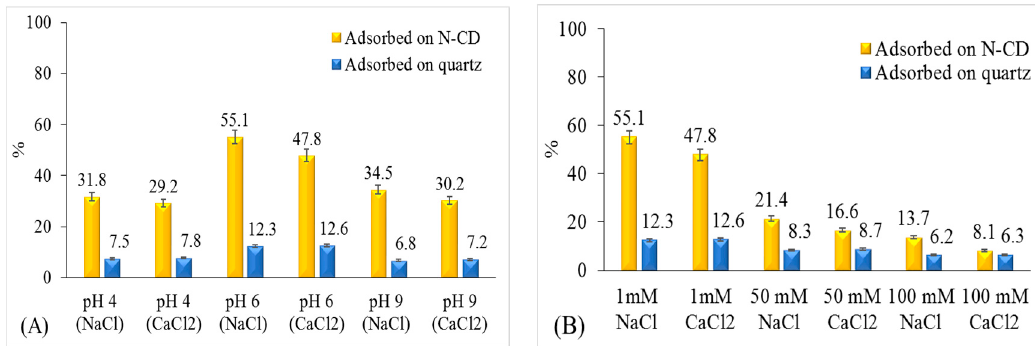
Figure 3. Batch experiments of Pb adsorption on N-CD and CD under different pH ( A ). Ionic strength (IS) ( B ). Ten grams quartz, 25 mL Deionized water, N-CD/CD: 50 mg.L − 1 , Cu: 10 mg. L − 1 , and equilibrium time 120 min, background solution containing: NaCl (1 mM), NaHCO 3 (1 mM).